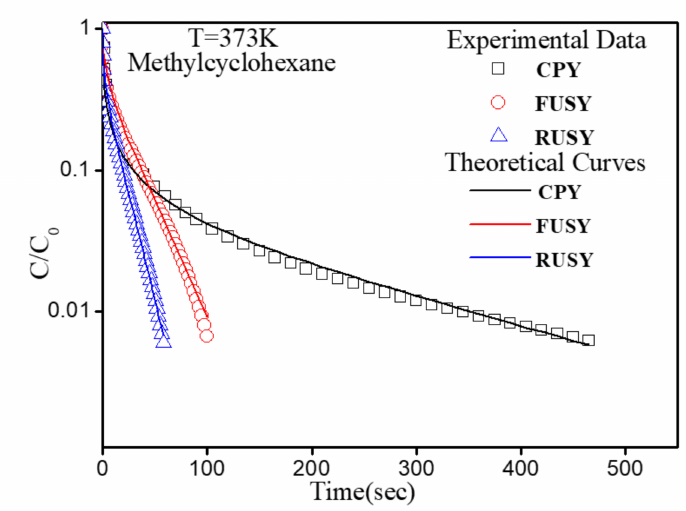
Figure 3. ZLC desorption curves at 373 K for methylcyclohexane on the three Y-zeolite samples.